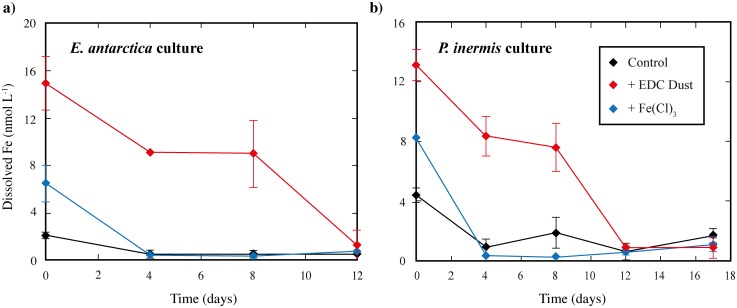
Dissolved Fe concentration (nmol L-1) measured in cultures of a) Eucampia antarctica or b) Proboscia inermis under different conditions (control, +EDC Dust, +FeCl3) by Flow Injection Analysis.The initial values were measured in the 8 L canister, prior to subdivision into five 1 L bottles, and these values are shown for time = 0. After this, the mean of measurements in the replicate bottles is shown (n = 3 or n = 5 for final measurement), with error bars denoting ± 1SD (where bigger than the size of the symbol).